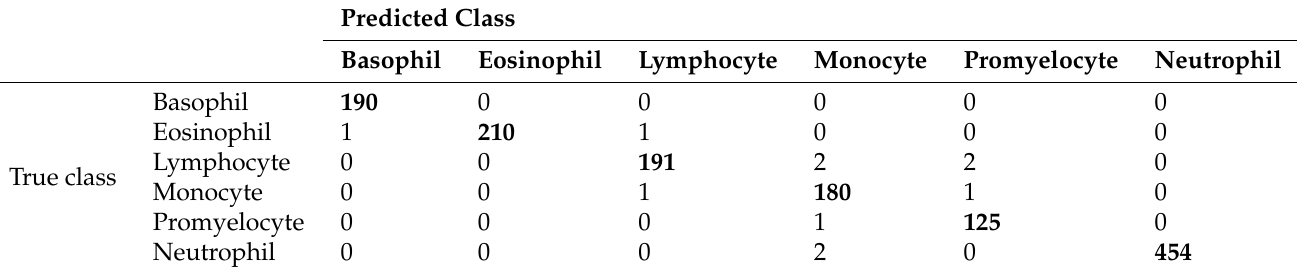
Table 10. The confusion matrix of the classification performance of the four models for the testing data of the combination of two public datasets; each number represents the number of cells